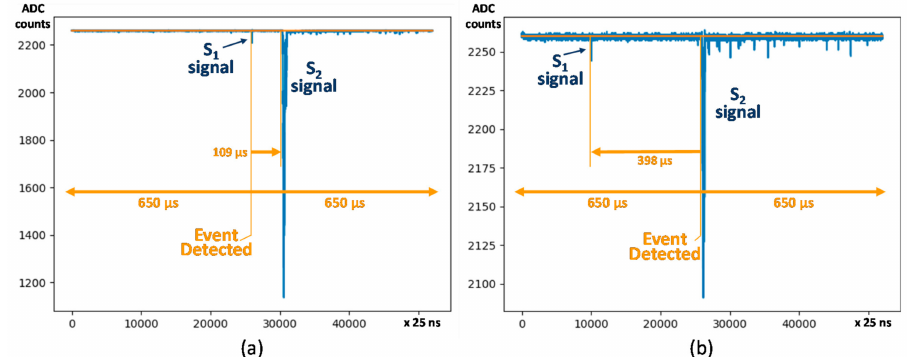
Figure 2. NEXT-White most common signal searches: ( a ) Online S 1 signal search, with offline S 2 signal search; ( b ) Online S 2 signal search with offline S 1 signal search. In both cases, a data acquisition window of 1300 µ s and pre-trigger of 650 µ s is